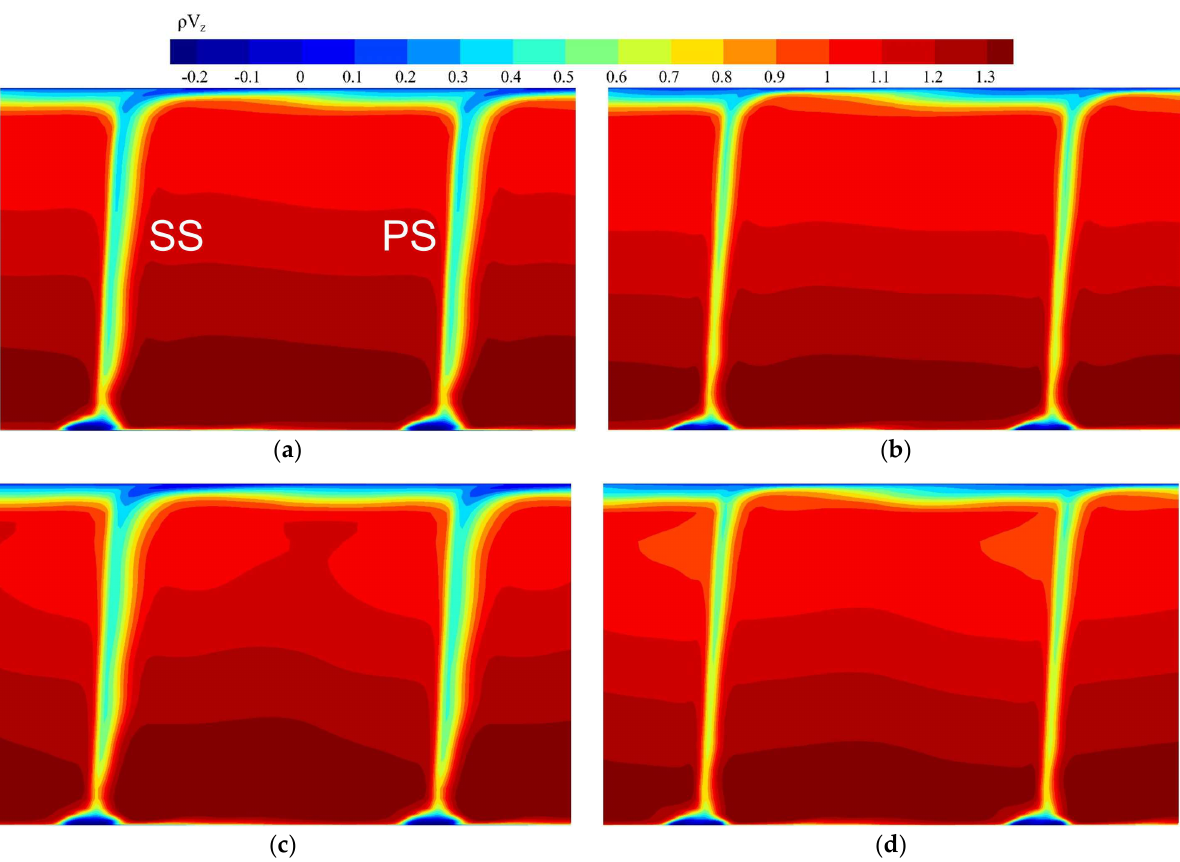
Figure 8. Distribution of axial velocity density flow of 10% chord length section after the rotor. ( a ) Re = 1 × 10 5 , without wake; ( b ) Re = 4 × 10 5 , without wake; ( c ) Re = 1 × 10 5 , with wake; ( d ) Re = 4 × 10 5 , with wake.